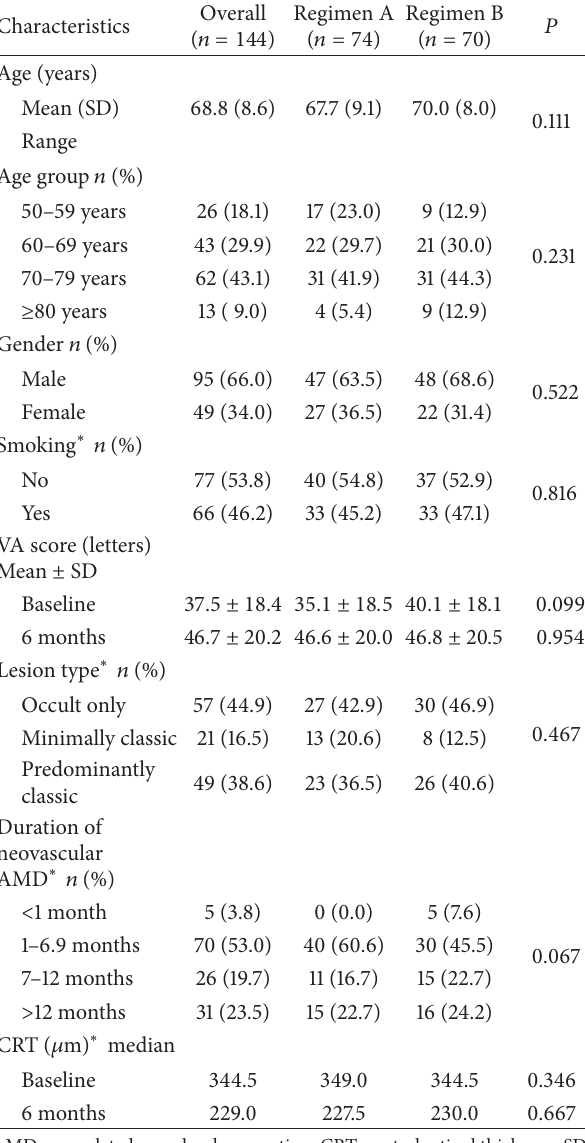
Table 1: Demographic and ocular characteristics of 144 patients in two regimens.